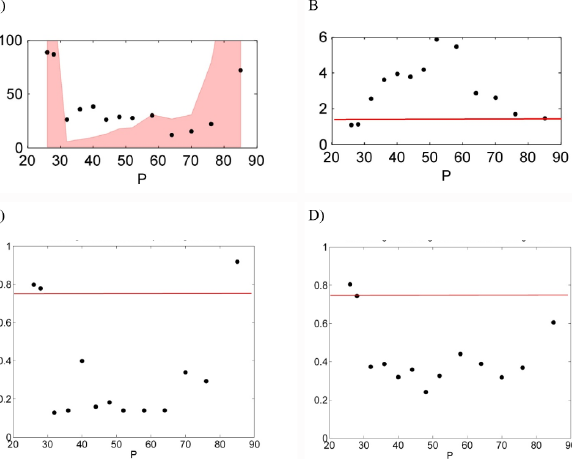
Fig. 13. Statistical analysis of the vegetation clusters for the fields of vegetation obtained by varying average net radiation. (A) Mean size of clusters and range 0.025–0.975 quantile of the mean cluster size corresponding to a binomial process with the same percent- age cover. (B) Mean ratio between the span in the x-direction and the span in the y-direction of each cluster; red line represents the boundary between spots and bands. (C) Percentage of the domain filled by the largest cluster; red line represents the minimum fraction of area filled for the field to be considered labyrinthine. (D) Fraction of area of the largest cluster filled by vegetation; red line represents the maximum fraction of the largest cluster that can be filled for the field to be considered labyrinthine.